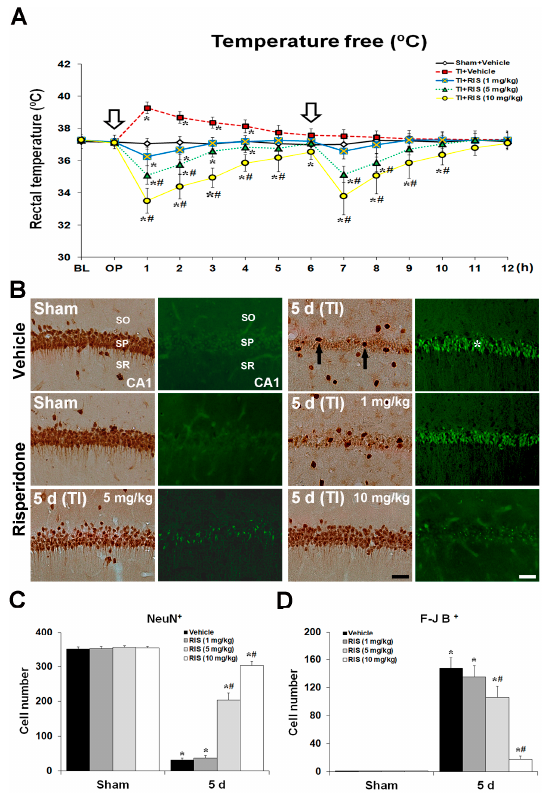
Figure 1. E ff ects of risperidone (RIS) against transient ischemia (TI) injury under uncontrolled body temperature (UBT) condition. ( A ) Changes in body temperature under UBT condition for 12 h after TI. Body temperature is significantly low in the TI + 10 mg / kg RIS group compared to the TI + vehicle group. White arrows indicate times of RIS treatment. The bars indicate the means ± SEM, n = 7 / group, two-way analysis of variance (ANOVA) with a post-hoc Bonferroni’s multiple comparison test (* p < 0.05 vs. sham + vehicle group; # p < 0.05 vs. TI + vehicle group). ( B ) E ff ects of RIS on NeuN + and F-J B + cells in the CA1 under UBT condition after TI. In the sham + vehicle group, CA1 pyramidal neurons are well stained with NeuN; however, no F-J B + CA1 pyramidal cells are found. In the TI + vehicle group, a few NeuN + cells (arrows) are shown in the stratum pyramidale (SP) 5 days after TI; however, the distribution of NeuN + cells in the TI + RIS group is similar to that in the sham + vehicle group. In the TI + vehicle group, many F-J B + cells (asterisks) are detected in the SP 5 days after TI, and many F-J B + CA1 pyramidal cells (asterisks) are detected; however, in the TI + RIS group, RIS produces a dose-dependent increase in the number of NeuN + CA1 pyramidal neurons, and a dose-dependent decrease in the number of F-J B + CA1 pyramidal cells 5 days after TI. CA1, cornu ammonis 1; CA3, cornu ammonis 3; DG, dentate gyrus; SO, stratum oriens; SR, stratum radiatum. Scale bar = 50 µ m. Note histograms of quantitative analyses of NeuN + and F-J B + cells in all the groups, as shown ( C ) and ( D ). The bars indicate the means ± SEM, n = 7 / group, two-way analysis of variance (ANOVA) with a post-hoc Bonferroni’s multiple comparison test (* p < 0.05 vs. sham + vehicle group; # p < 0.05 vs. TI + vehicle